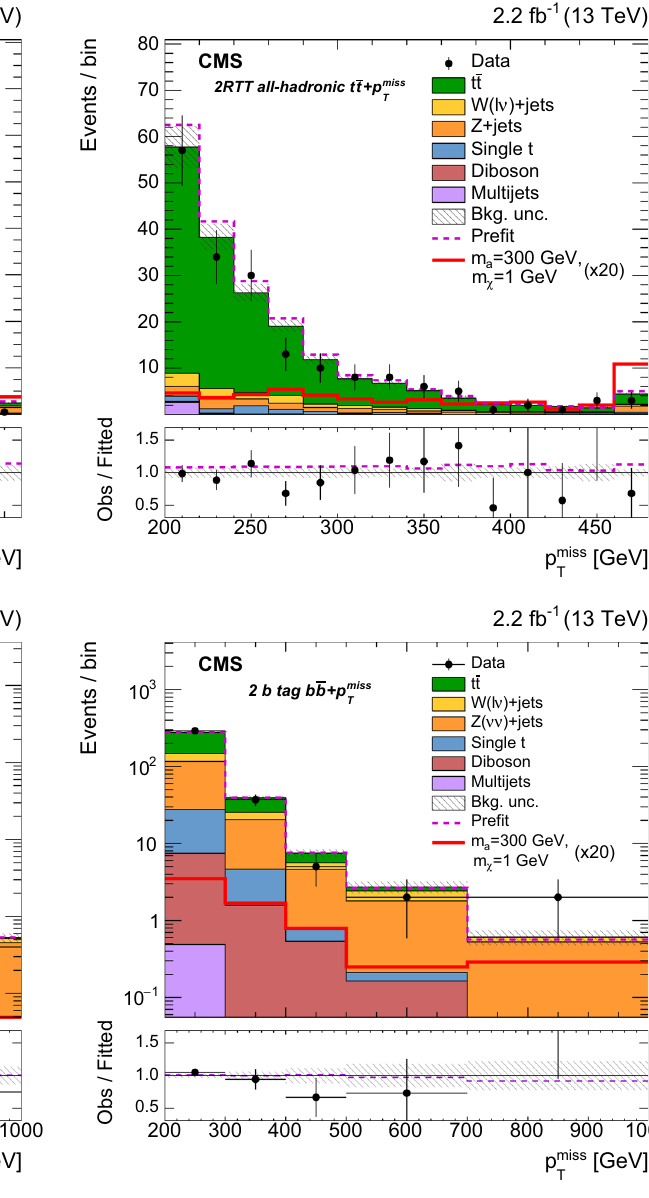
Fig. 10 The p miss distributions in the following signal regions: all- distribution of an example signal (pseudoscalar medi- The prefit p miss T T ator, m a = 300 GeV and m χ = 1 GeV) is scaled up by a factor of 20. hadronic tt + p miss with 0 or 1 RTTs (upper left), all-hadronic tt + p miss T T The last bin contains overflow events. The lower panels of each plot with 2 RTTs (upper right), bb + p miss with 1 b tag (lower left), and T show the ratio of observed data to fitted background. The uncertainty bb + p miss with 2 b tags (lower right). The p miss distributions of back- T T bands shown in these panels are the fitted values, and the magenta lines ground correspond to background-only fits to the individual tt + p miss T correspond to the ratio of prefit to fitted background expectations and bb + p miss signalregionsandassociatedbackgroundcontrolregions. T